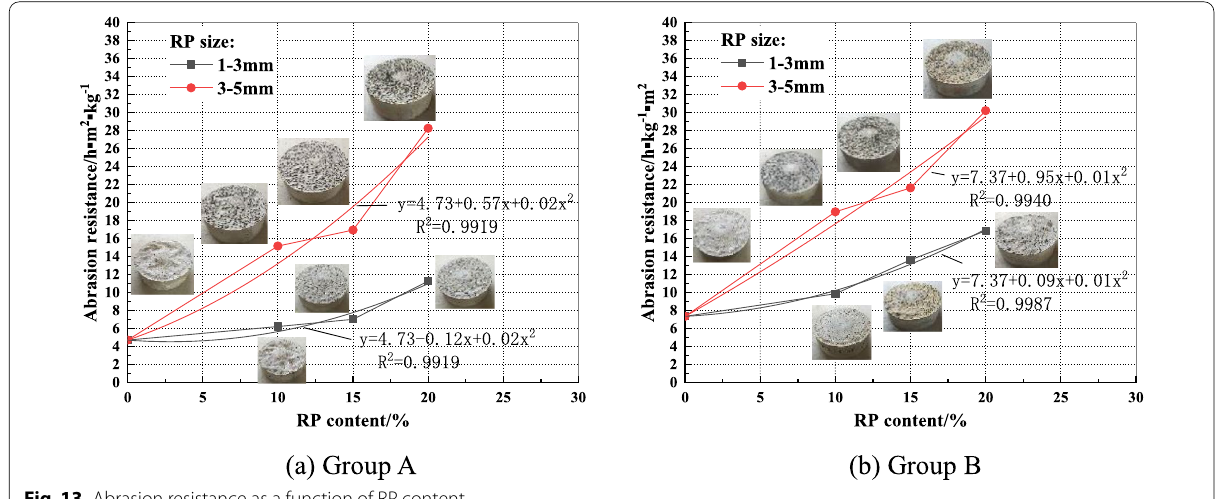
Fig. 13 Abrasion resistance as a function of RP